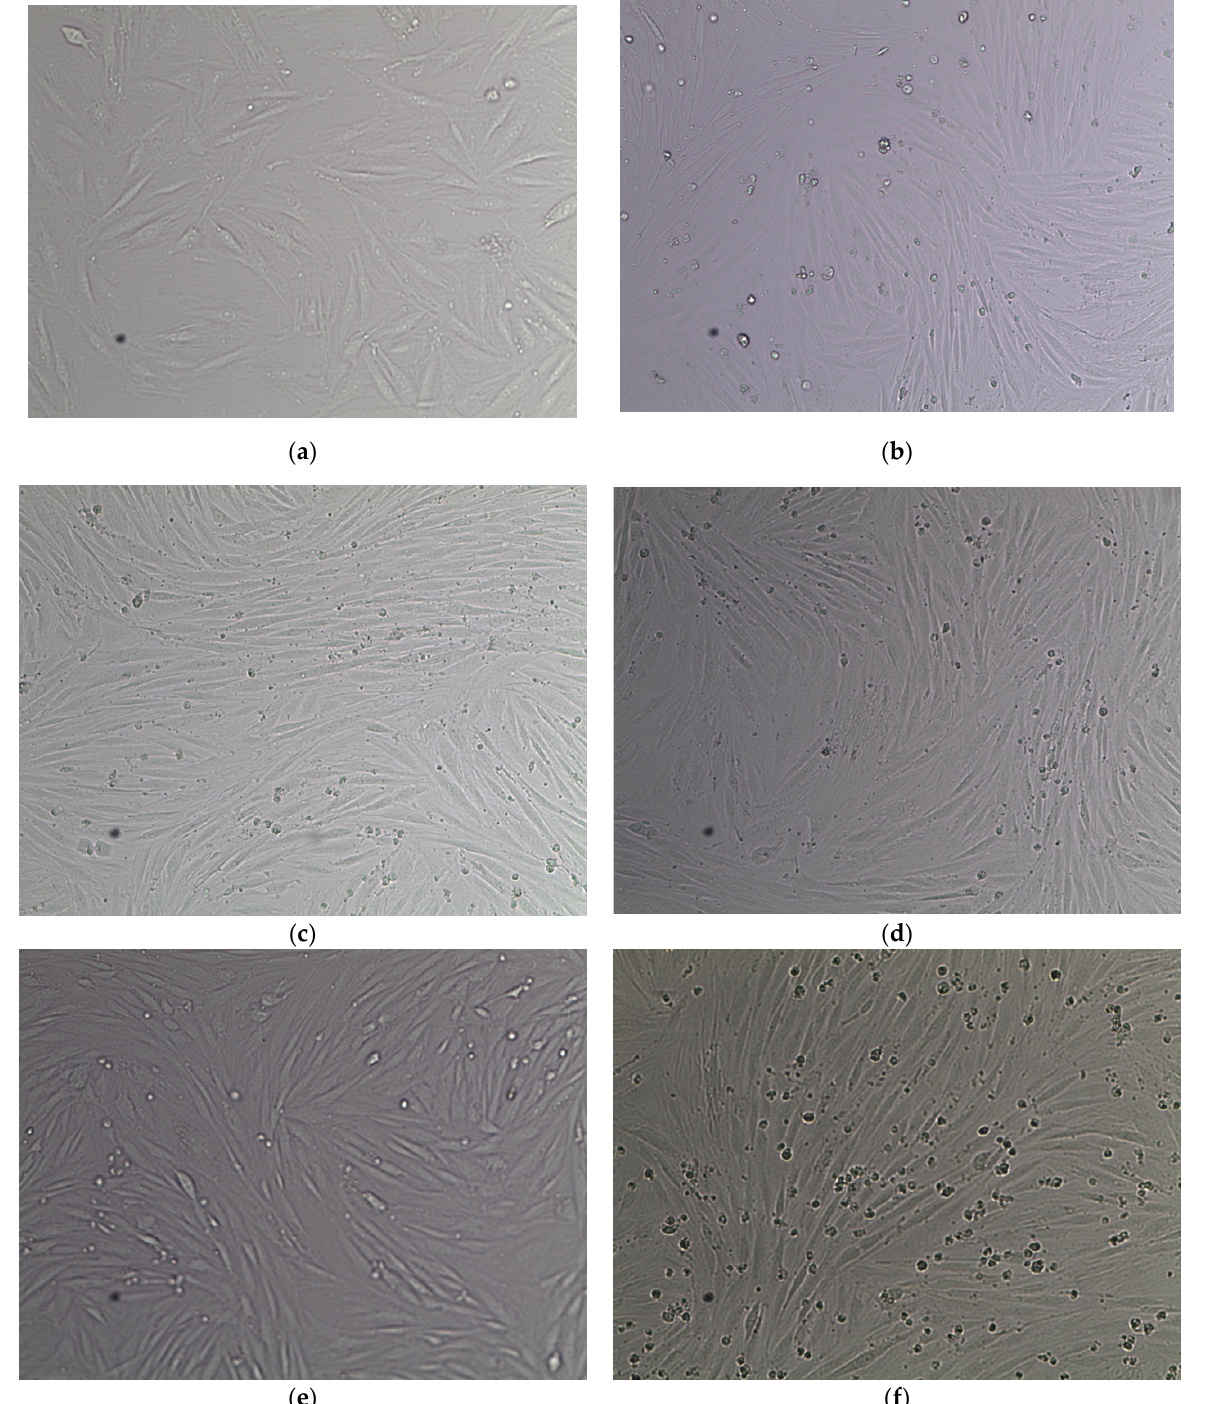
Figure 1. Images depicting L6 skeletal muscle myoblasts from rats, differentiated into L6 skeletal muscle myotubes (passage 7). ( a ) Myoblasts obtained on day 3 of the tissue culture in 10% FBS Ham F-10 media (10×). ( b ) Cells obtained on day 4 of the tissue culture in 6% horse serum Ham F-10 media (10×). ( c ) Myotubes obtained on day 5 of the tissue culture in 2% horse serum Ham F-10 media (10×). ( d ) Myotubes obtained after 4 h of tissue culture in 2% delipidated serum Ham F-10 media (10×). ( e ) Myotubes obtained after one hour of cell starvation in only Ham F-10 media (10×). ( f ) Myotubes obtained after 19 h of cell starvation in only Ham F-10 media (10×).